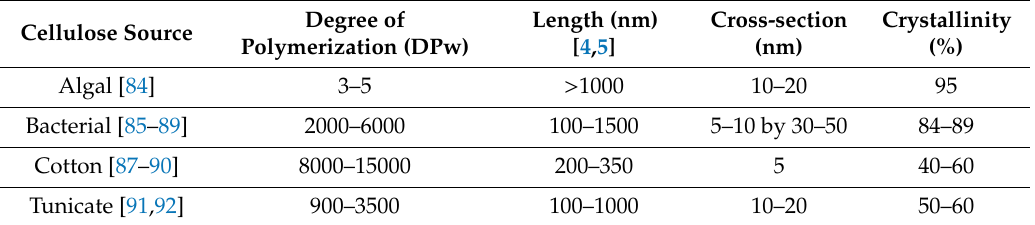
Table 3. Geometrical domain scale and properties of cellulose nanocrystals (CNCs) according to sources. Cellulose